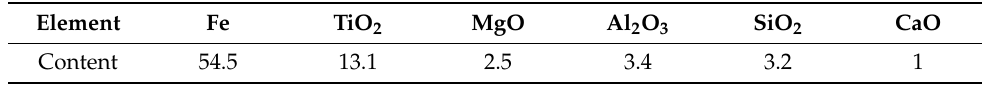
Table 1. Chemical analysis of TC sample